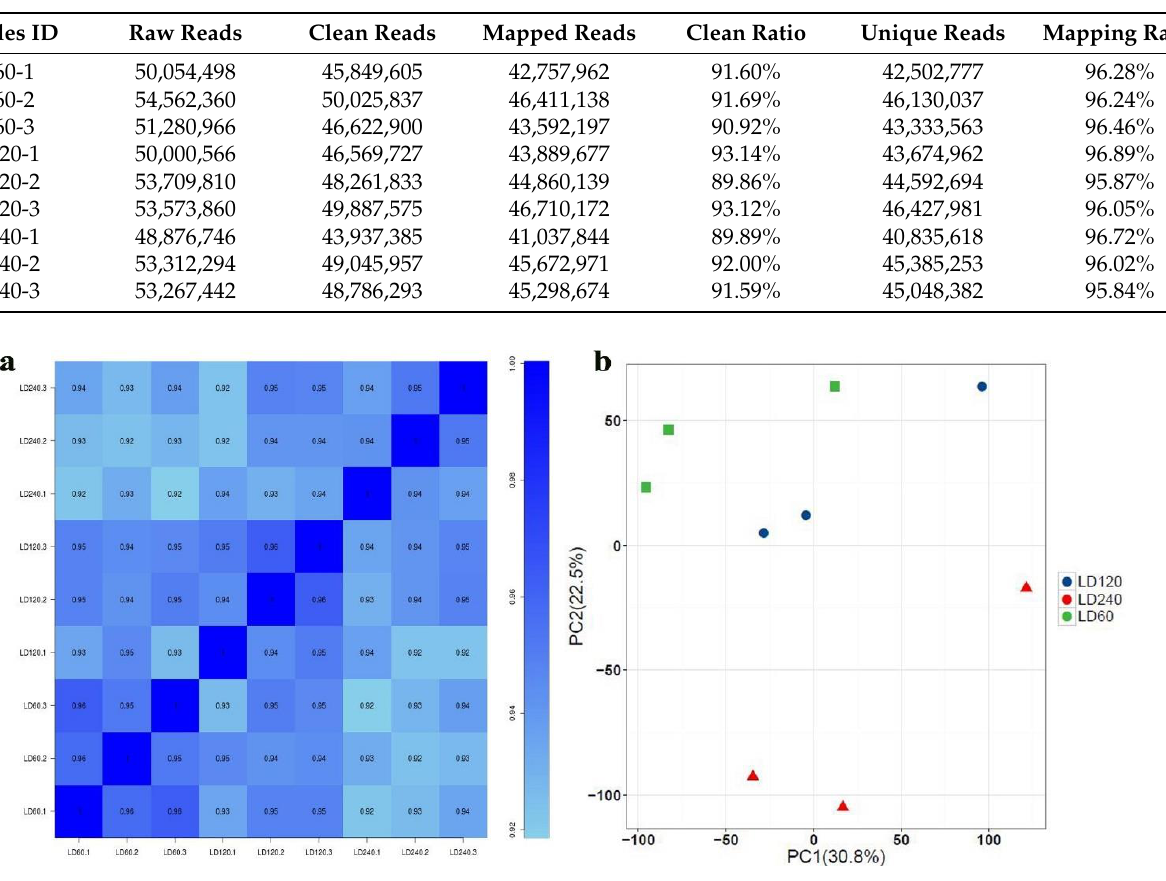
Figure 2. Cluster analysis and PCA. ( a ) Heatmap of correlation coefficients between LD muscles at different developmental stages of WH pig. ( b ) Principal components analysis (PCA).